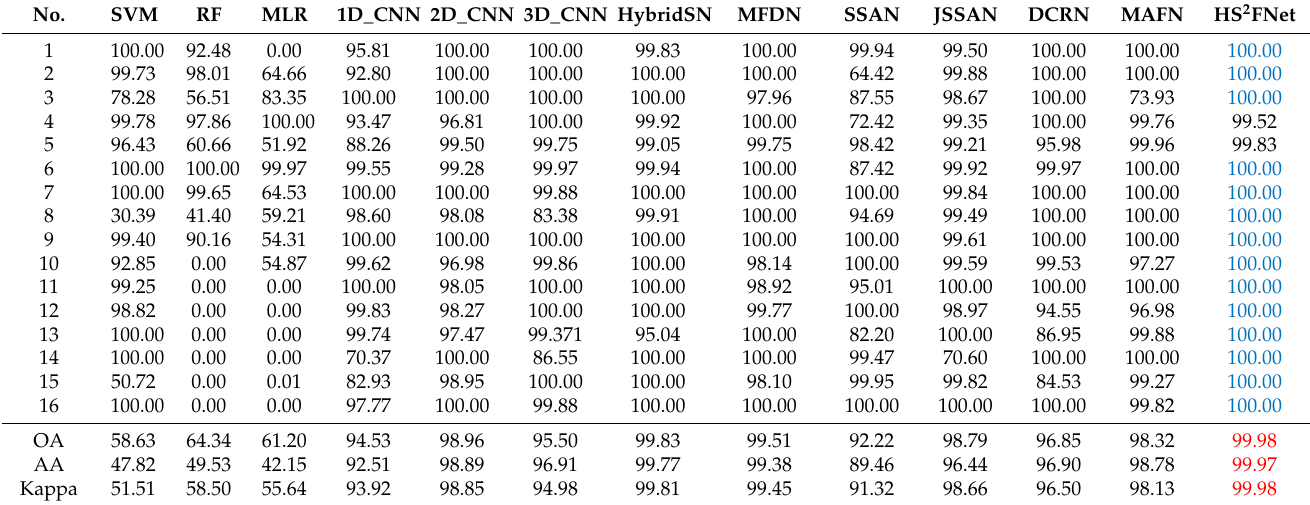
Figure 11. The visual comparisons of the state-of-the-art models and our network on KSC dataset.